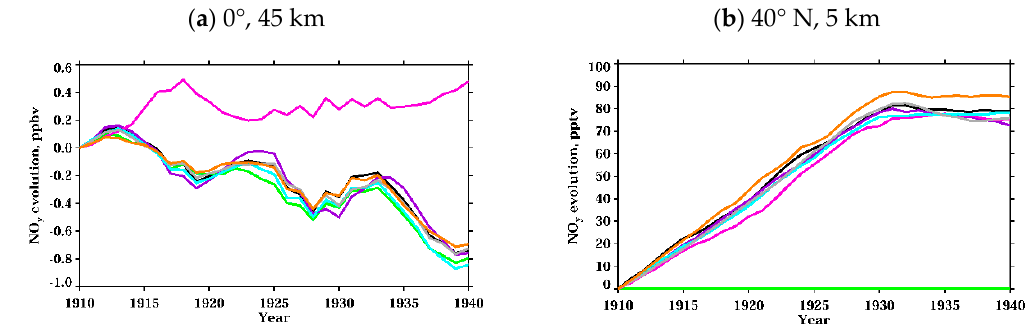
Figure 4. The evolution of annual and zonal mean NO y since 1910. ( a ) In the tropical upper stratosphere panel; ( b ) in the lower troposphere over northern midlatitudes panel. The lines are black for ALL, violet for noEPP, magenta for fixUV, light blue for fixVIS / IR, green for fixGHG, orange for fixWMGHG, and grey for noVOL experiments.